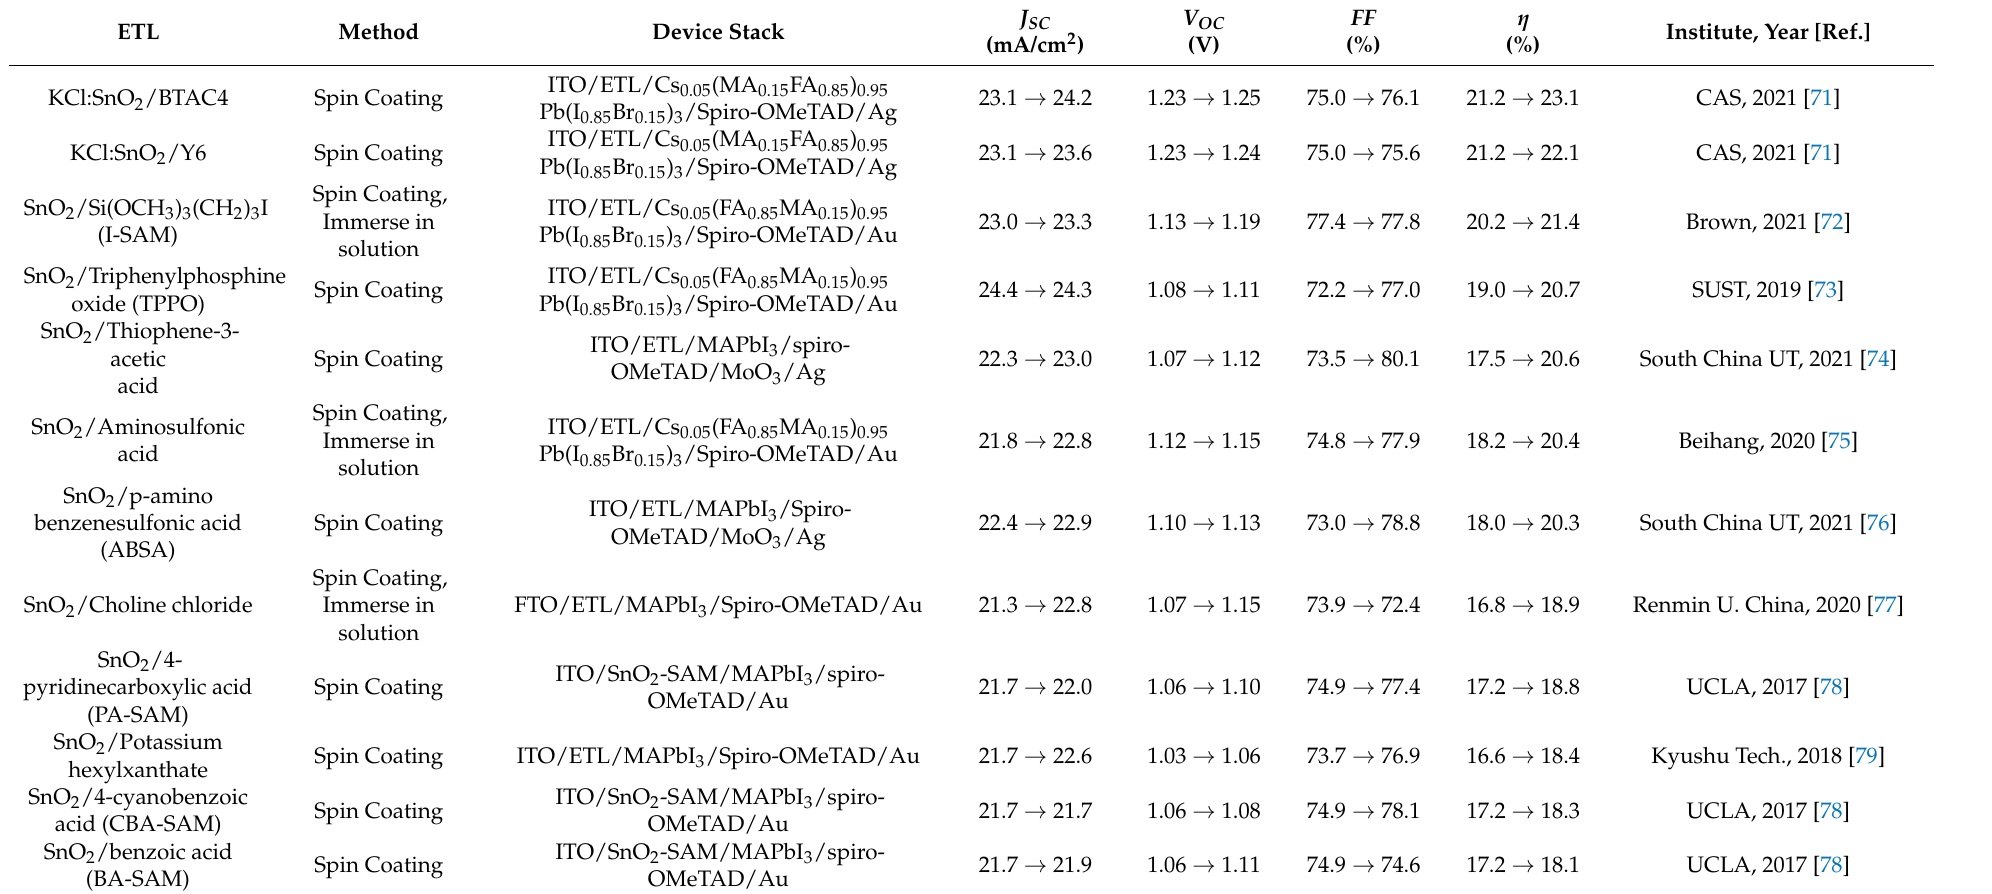
Table 7. Summary of perovskite-solar cells based on surface modification of SnO 2 ETL by organic